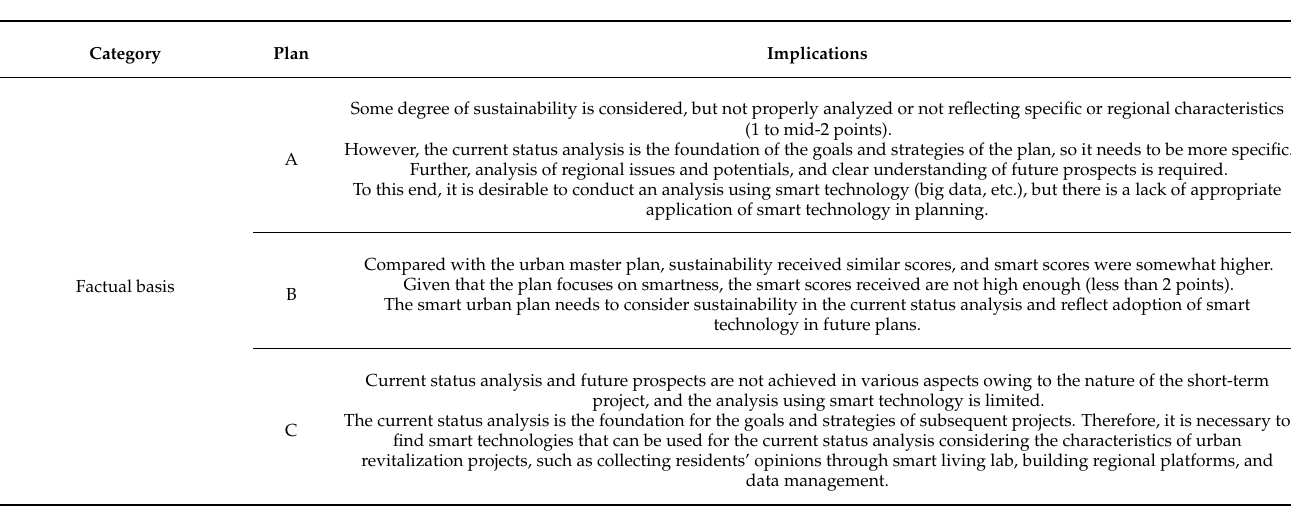
Table 3. Considerations for